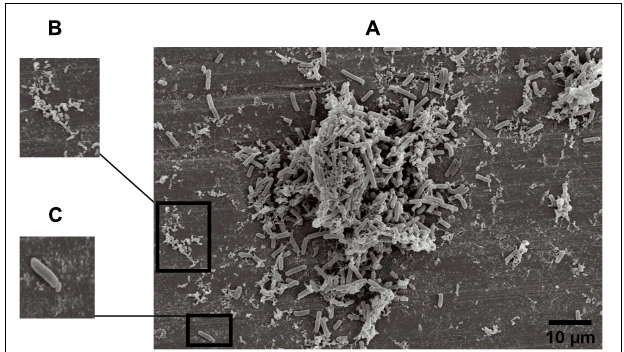
FIGURE 3 | Image obtained by SEM (JEOL) of microbial cooperative interaction of L. monocytogenes and B. cereus (+). Experiment 1, Group 3, on stainless steel (A) ; L. monocytogenes (B) ; and B. cereus (C)